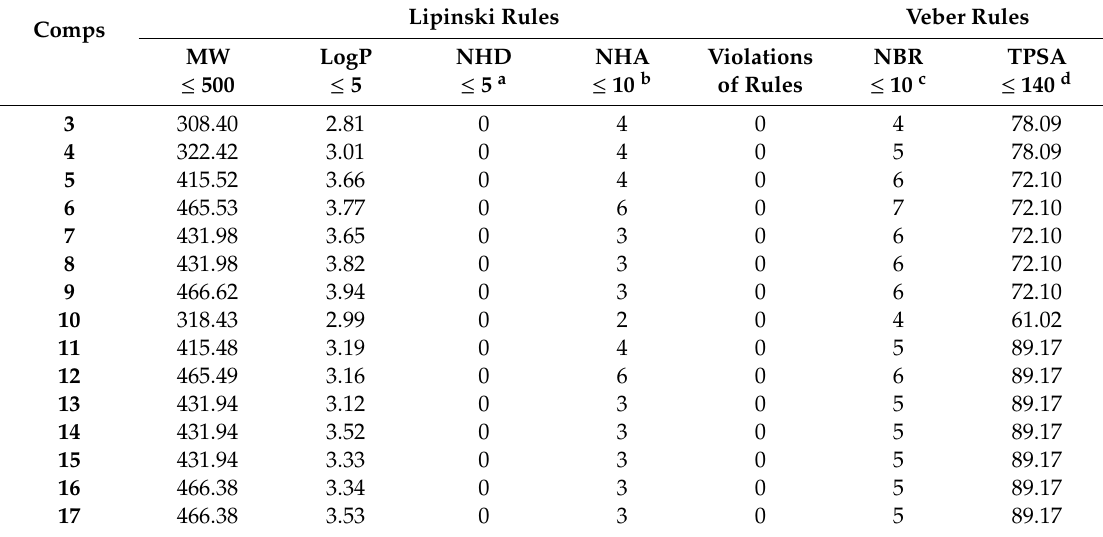
Table 1. Drug-likeness parameters according to Lipinski and Veber rules.